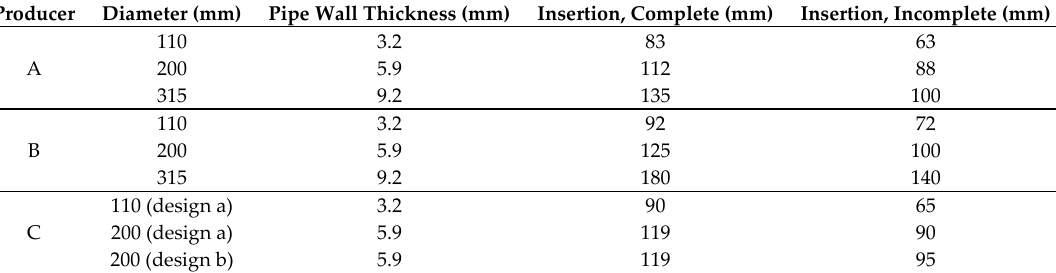
Table 1. Some relevant dimensions of the different simulated